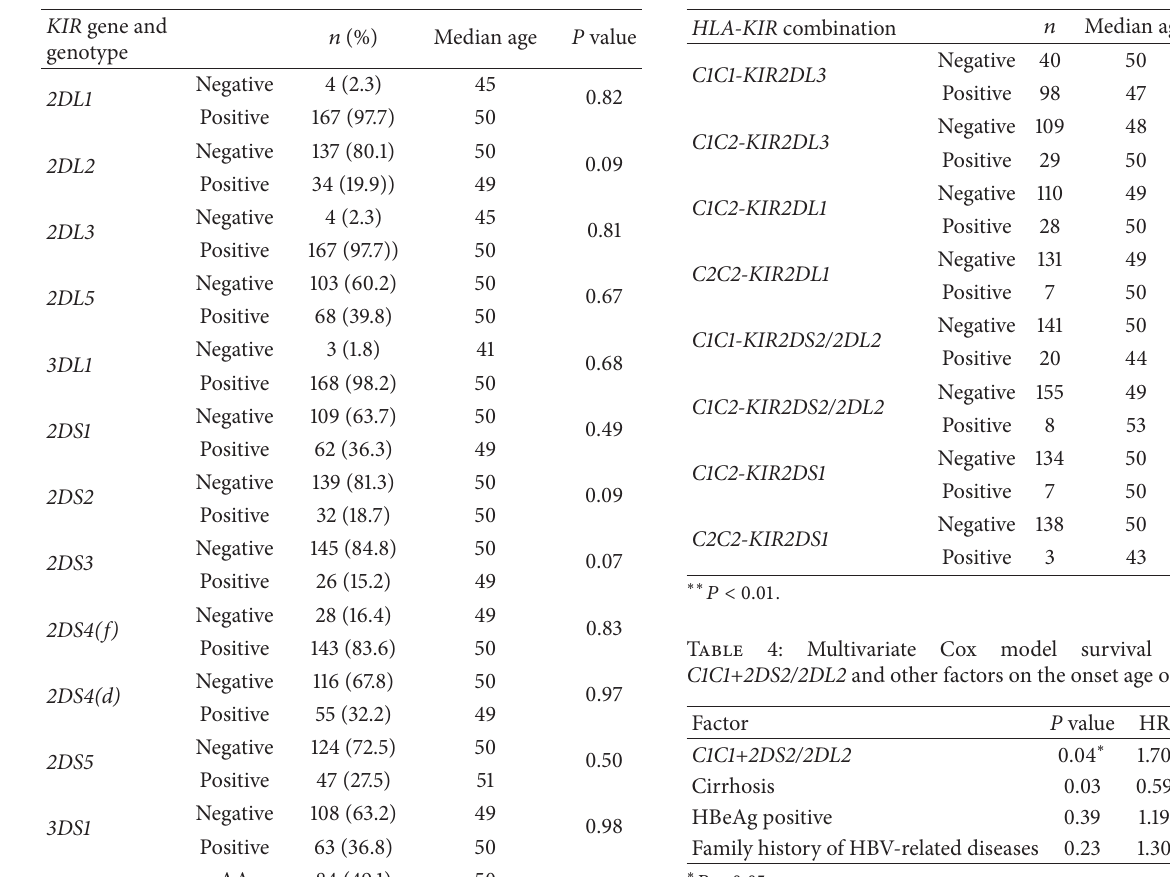
Table2:Effectsof KIR genesandgenotypesontheonsetageofHCC by KM analysis.